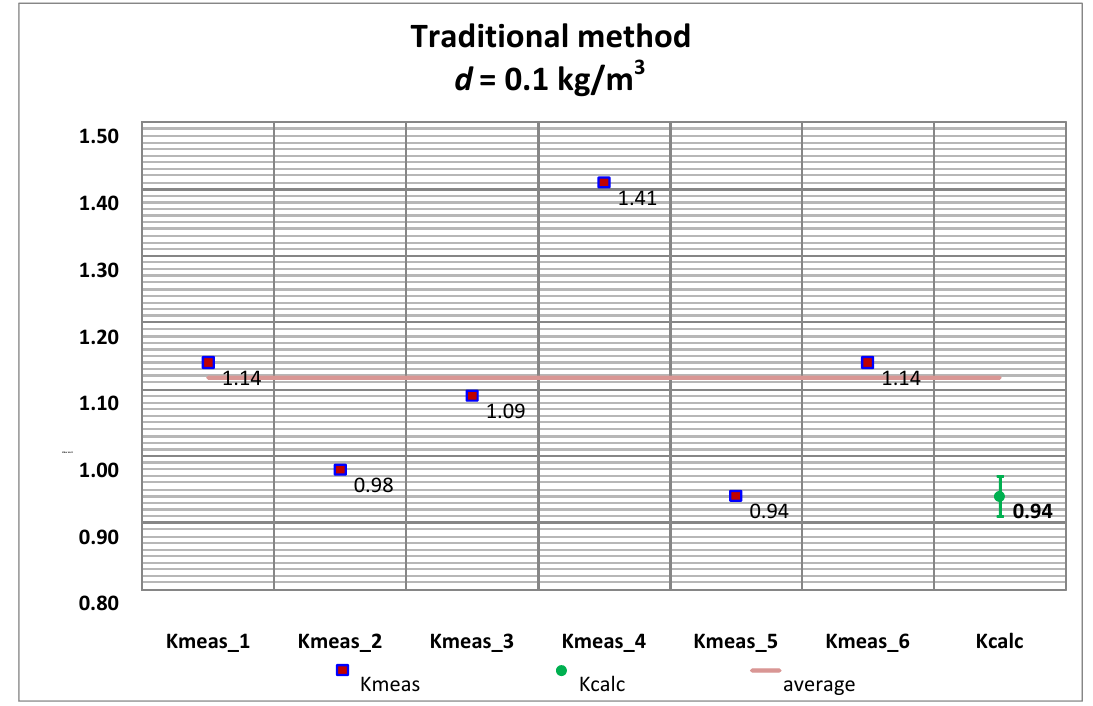
values. High accuracy hydrometer. Traditional Figure 20. K meas